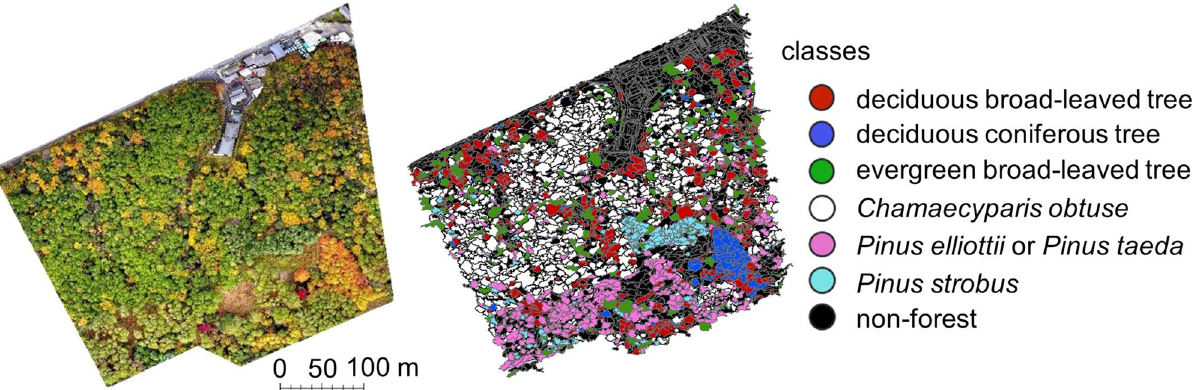
Figure 3. Segmentation and ground truth map-making result. The tree classes found in the image on the left are represented by the colours explained in the legend in the figure on the right. This figure was